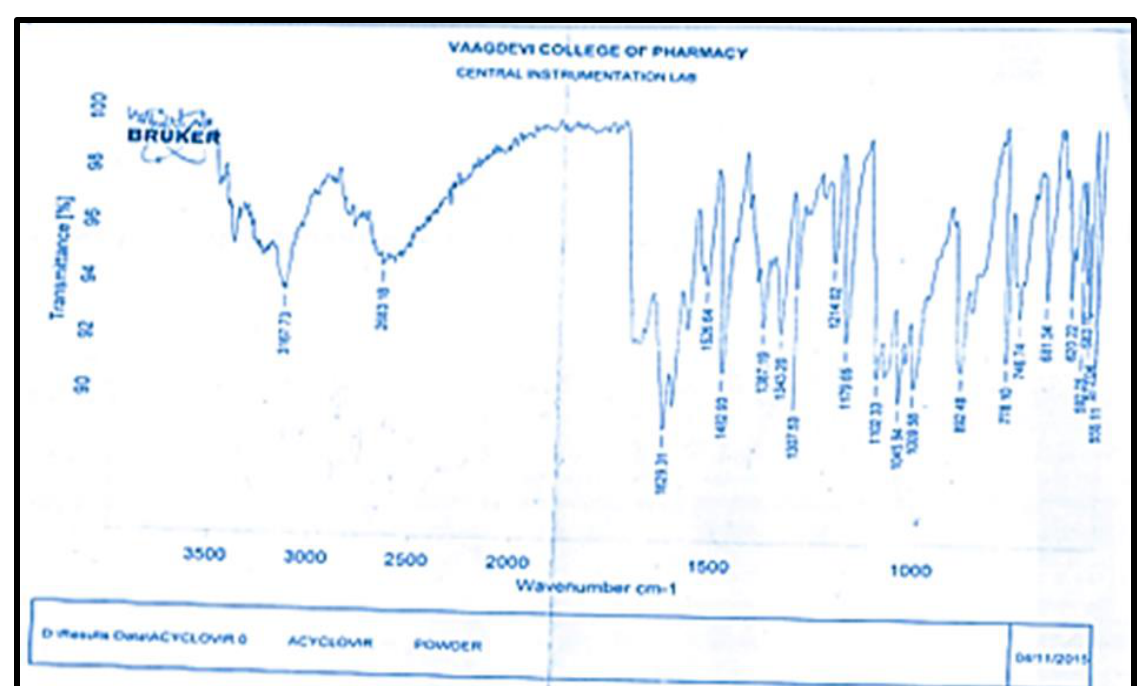
Figure 2. FTIR spectra of pure drug and